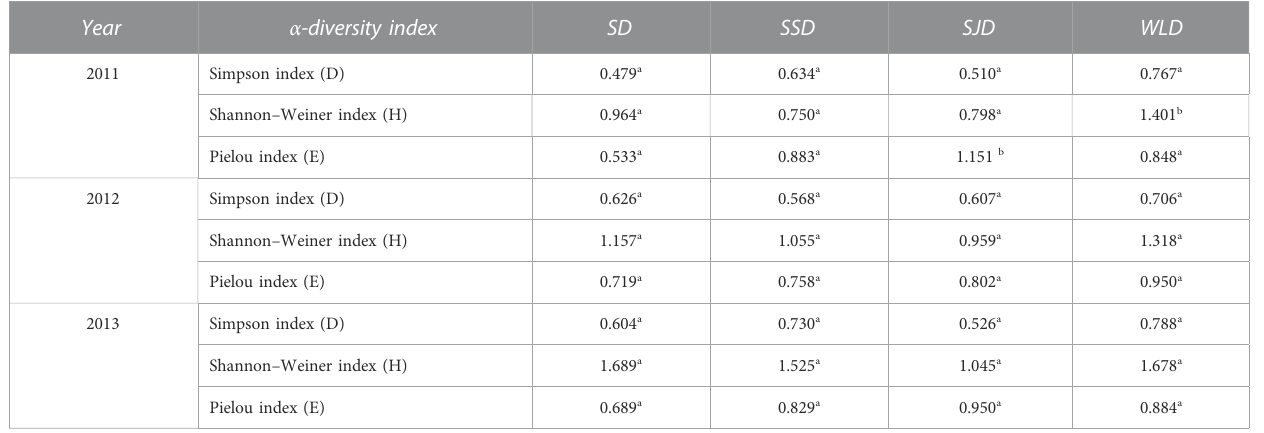
TABLE 4 α -diversity of communities on study sites (2011 –